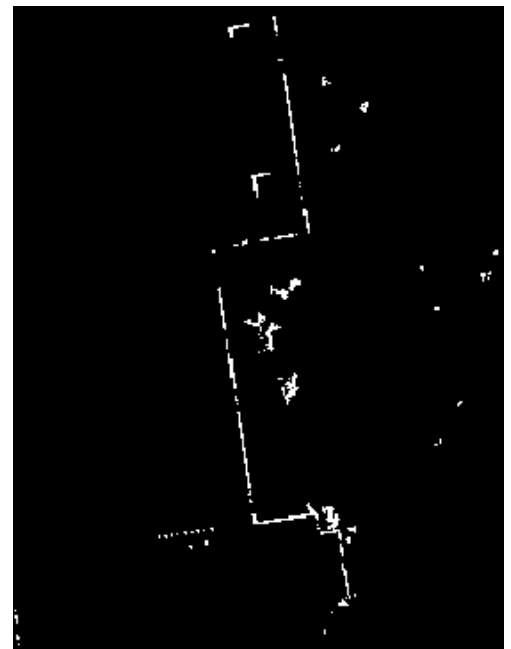
Figure 2. Cross section image of second point cloud at zero rotation